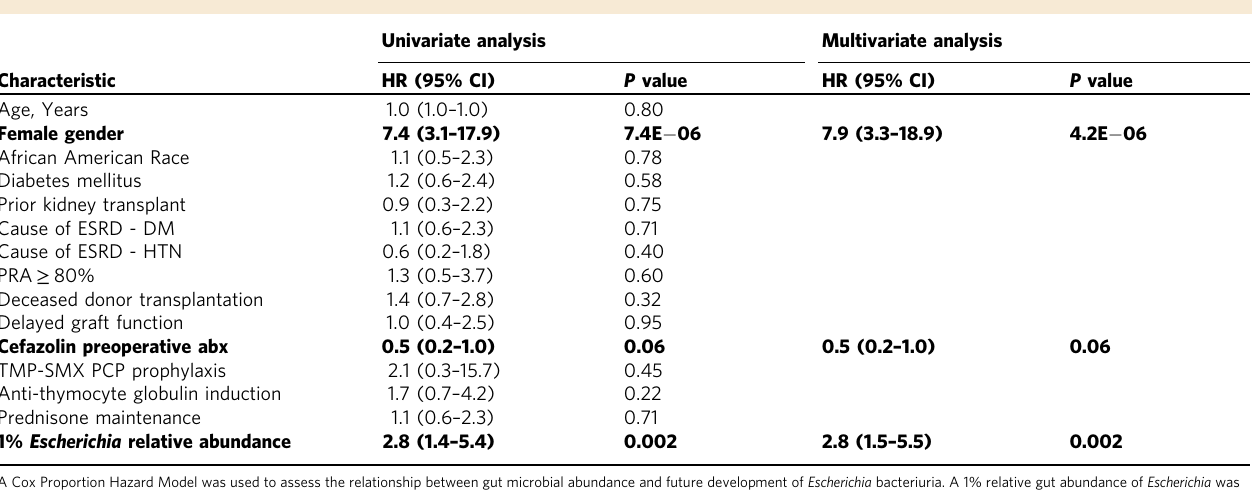
Table 1 Gut microbiota abundance and future development of Escherichia